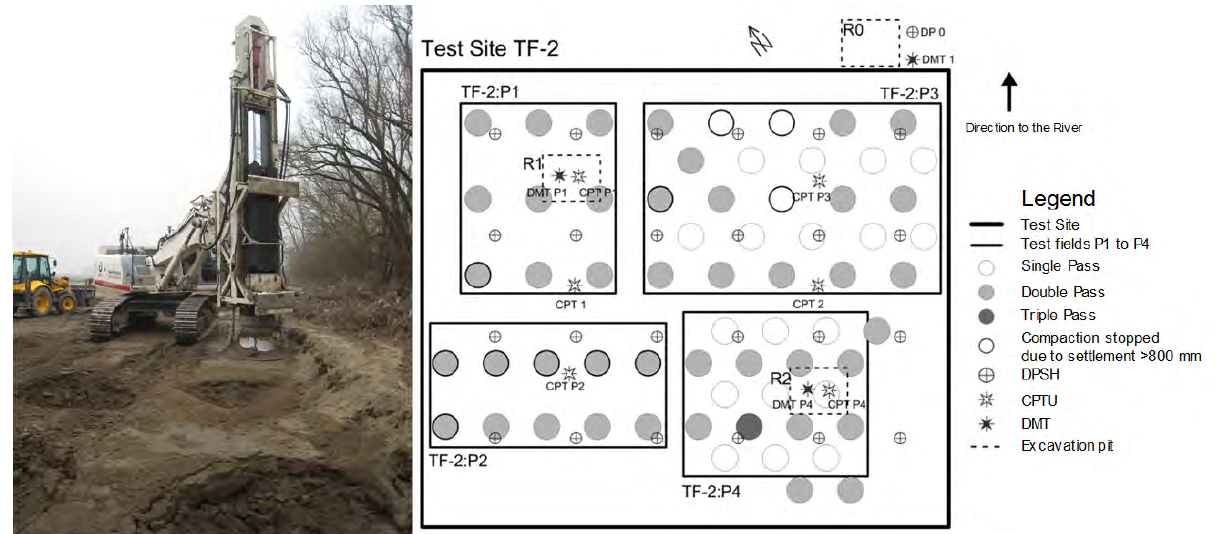
Figure 13. RIC during compaction (left) and the test site ES 2 layout (right – adapted from Vukadin, [20]).